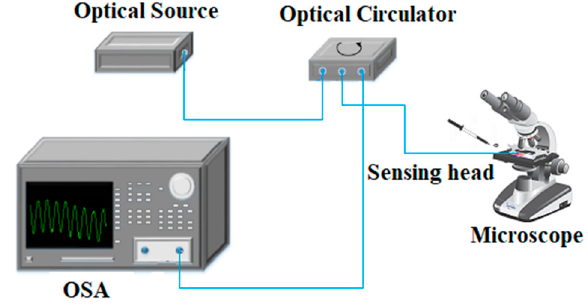
Figure 5. Experimental setup for paracetamol crystallization process monitoring.